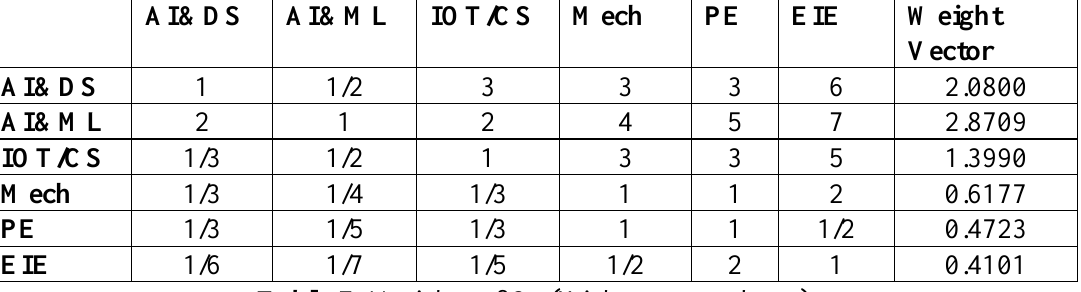
Table 7: Weights of C